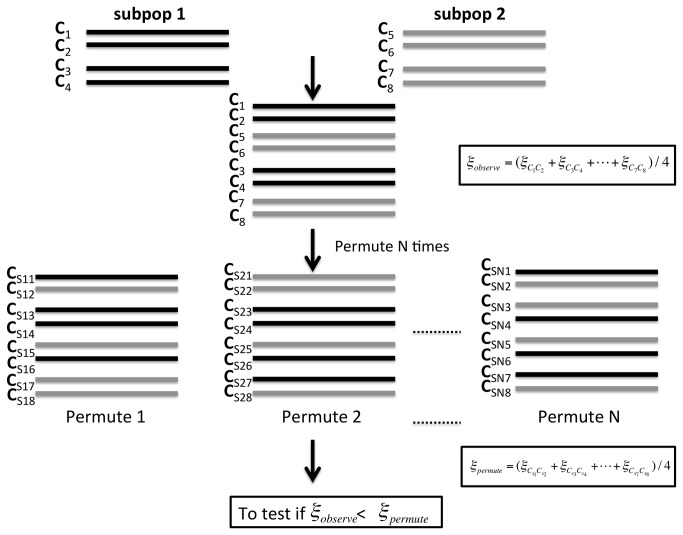
A diagram of the MCP method.In this case, a sample of n = 4 individuals was drawn from a population of interest. Gamete sequences (2n) of the individuals are denoted by C1-C8 as follows: C1 and C2 are from individual 1, C3 and C4 are from individual 2 and so on. After permuting these sequences N times (where N is any positive integer), N new datasets were obtained by dividing each permuted sequence into n consecutive pairs. For each permutation, the ξ
permute statistic could be calculated. This allowed us to derived the null distribution of the statistic. After locating ξ
observe on the null distribution, a p value of the test could be obtained.